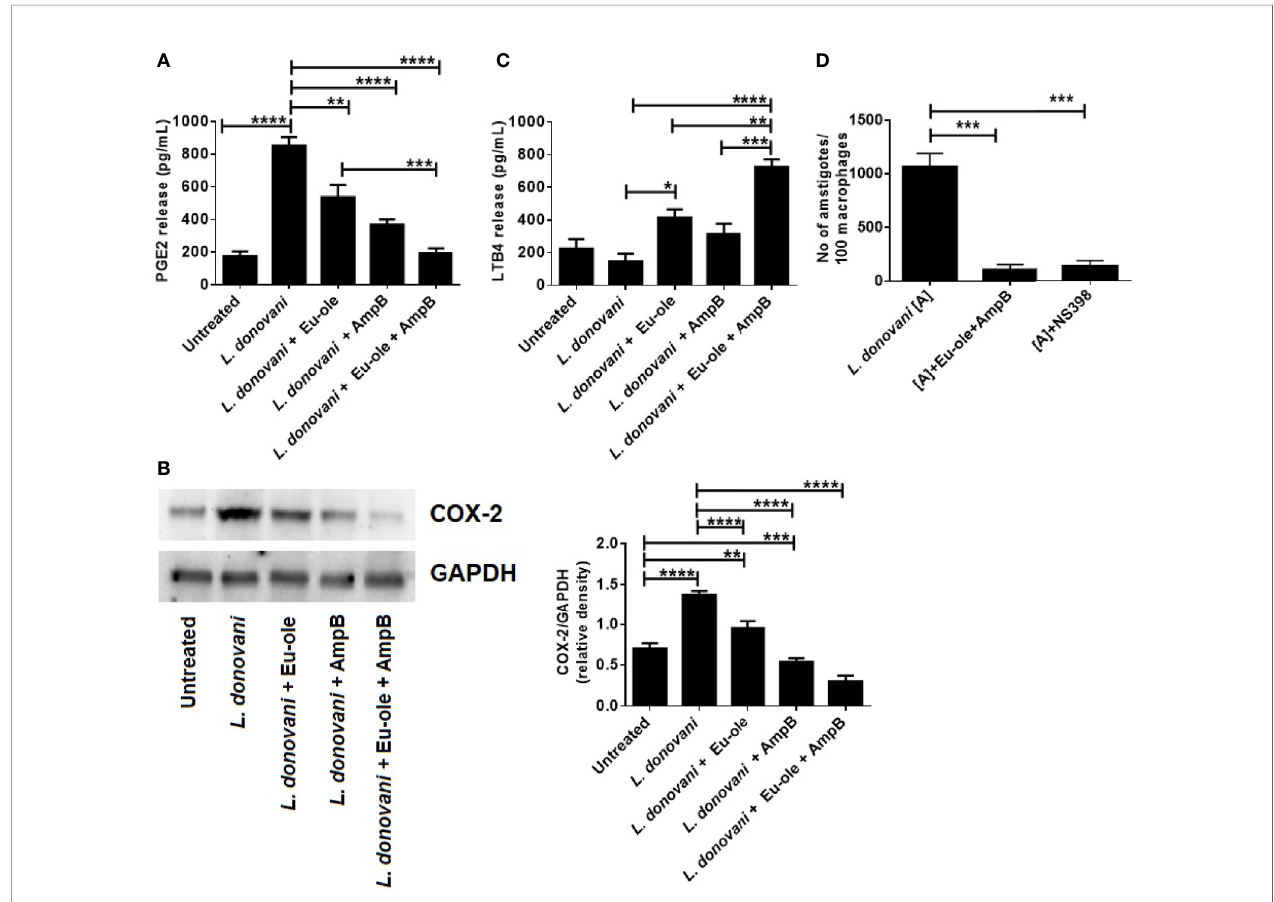
FIGURE 3 | Effect of combination therapy in PGE2 release by COX-2 mediated pathway with induction of LTB4 release in infected macrophages. Cells were infected with L. donovani parasite at 1:10 ratio. After 24 hr of post infection treatment was given to macrophages. After 24 h of post treatment cell free supernatant was used to estimate PGE2 and LTB4 release by sandwich ELISA (A, C) . In a separate experiment after 24 hr of treatment at different concentration, the expression of COX-2 protein was assessed by immunoblotting assay, and the result of densitometry data is expressed as mean ± SD from triplicate experiments (B) . Cells were treated with combination of drugs or COX-2 inhibitor ((NS-398, 1µM). After 48 h of post treatment anti-amastigote study was performed by Giemsa staining method and represented as parasites per 100 macrophages (D) , *p < 0.05, **p < 0.01, ***p < 0.001, ****p < 0.0001, signi fi cant differences between the indicated